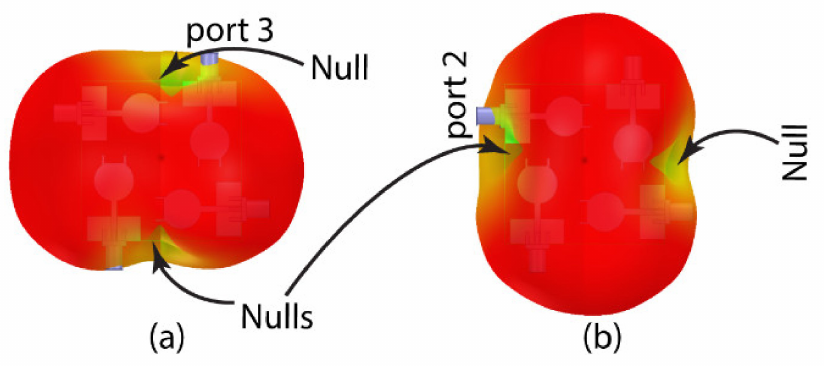
Figure 9. 3D radiation patterns at 3.5 GHz while exciting port ( a ) 3 only, ( b ) port 2 only. Furthermore, peak gain and efficiency of the antenna for the entire frequency band is reflected in Figure 10. The average gain of 4.5 dBi with more than 90% efficiency is reported for the entire spectrum to confirm the antenna functionality in the UWB